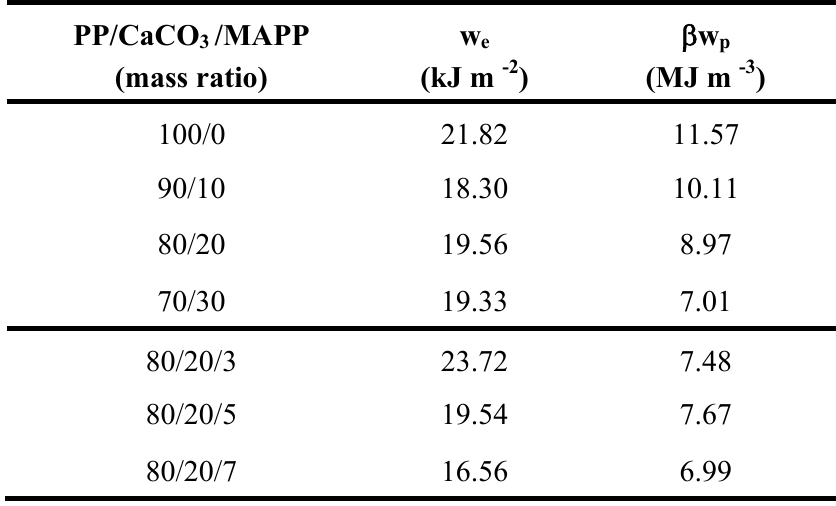
composites with several ratios of 3